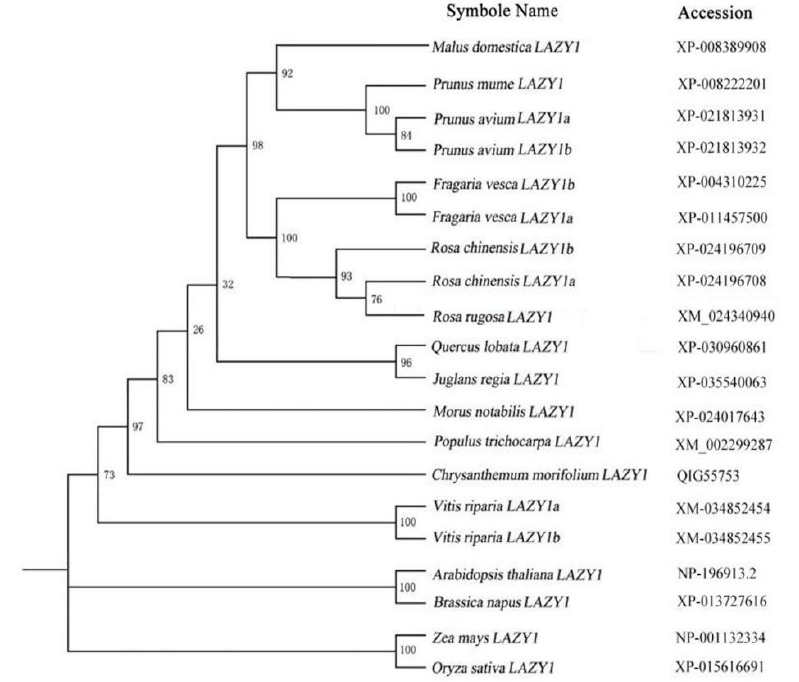
Figure 2. Phylogenetic analysis of RrLAZY1 and LAZY1 genes from other species.